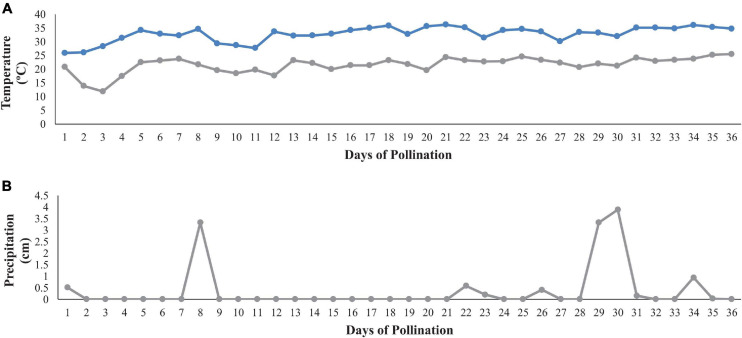
Maximum and minimum daily temperatures (A) and daily precipitation (B) during the estimated time of fruit set (3–7 weeks after transplanting). The x-axis represents the estimated number of days of pollination with diploid flowers opening ∼ 13 June 2019; climate data shown from 13 June to 18 July.